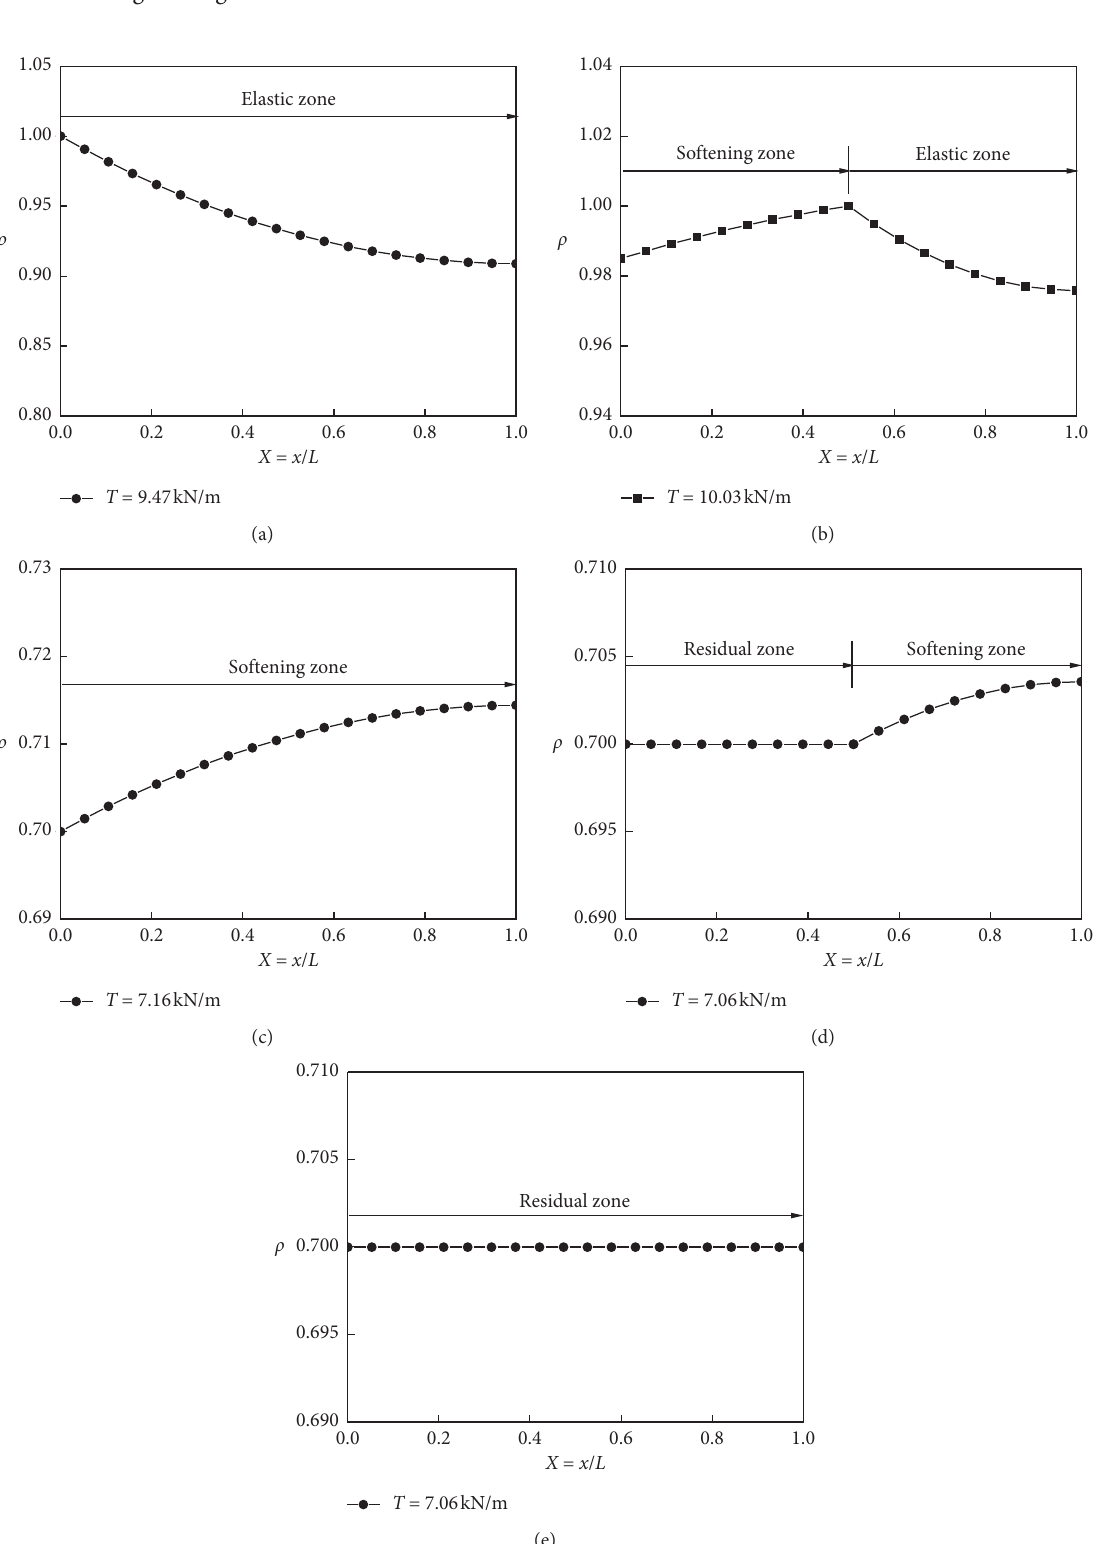
Figure 21: Evolution of the interfacial shear stress in the different stages of the pull-out process of the reinforced tailings (strain-softening reinforcement): (a) elastic stage; (b) elastic-softening transition stage; (c) pure softening stage; (d) softening-residual transition stage; and (e) pure residual